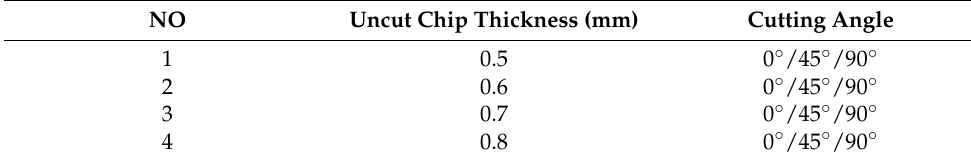
Figure 3. Cutting angle between tool and Haversian canal and its morphology of furrow. Table 2. Experiment